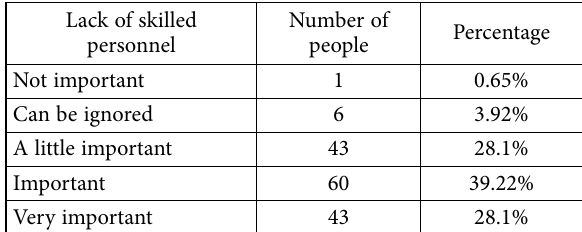
Table 9. Statistics table on the importance of lack of relevant skills and knowledge